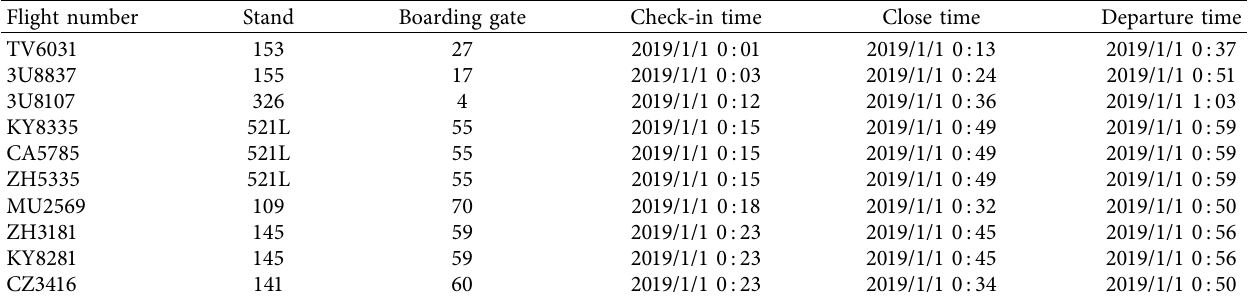
Table 2: Flight information (partial departure flight).